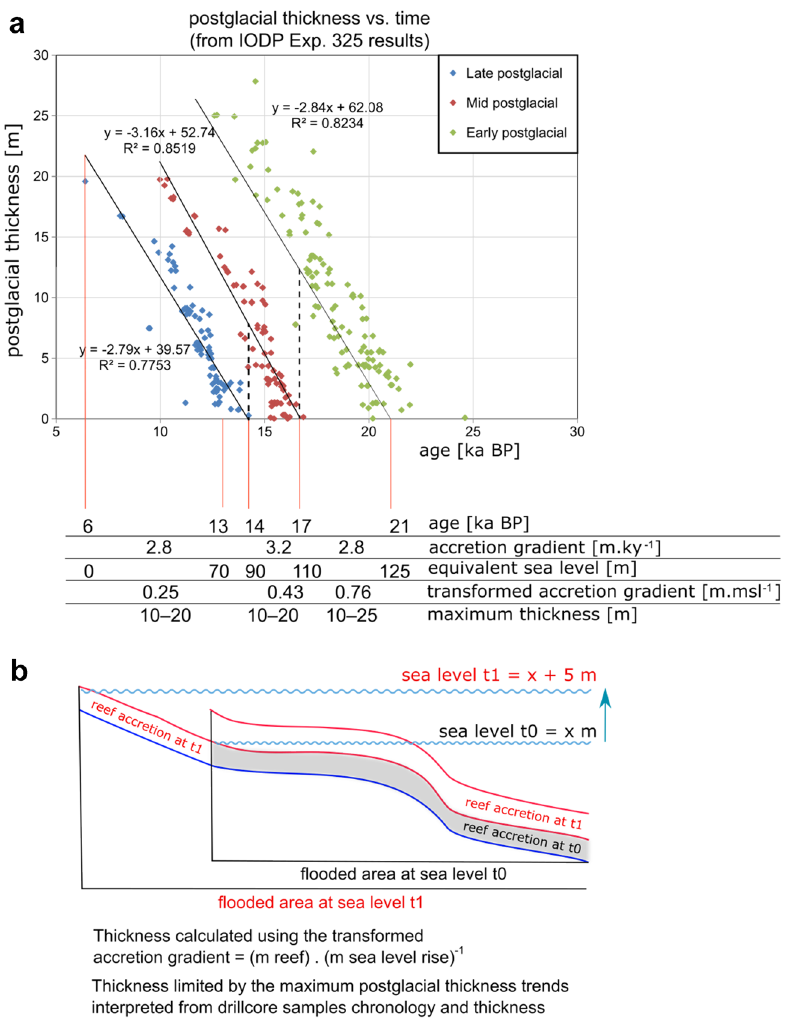
Figure 4. Description of the postglacial thickness method for the calculation of reef deposits: ( a ) Vertical accretion rates (VA) and maximum accretion thickness were extracted from trends of postglacial thickness vs. geological age using the dated core samples from the IODP Exp. 325 (Webster et al. 21 , Appendix 3). These rates were converted into an equivalent rate relative to the past sea level increase (transformed accretion rate VA SL ) using a composite sea level curve (Fig. 5, Appendix 6). ( b ) The marine-flooded areas for each postglacial sea level (FA SL ) 49 were multiplied by the thickness corresponding to one sea level step, according to the previously calculated rate VA SL . Flooded areas were not allowed to accumulate reef thickness beyond the maximum observed in ( a ). This can be represented as a thickness matrix ( b ) where each sea level step (t0, t1, …, tn) has a thickness vector applicable to the different flooded-area polygons (see Appendix 5 for full